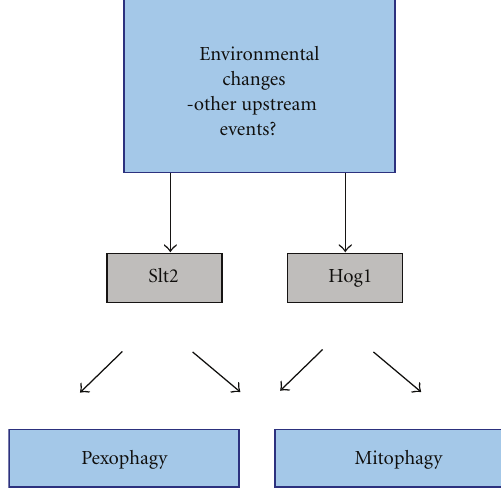
Figure 5: Signal transduction cascades regulating selective auto- phagy in yeast. Mitogen-activated protein kinase (MAPK) cascades contribute to di ff erential regulation of selective autophagy path- ways. As recently shown, the Slt2 and Hog1 signal transduction pathways regulate both mitophagy and pexophagy [37, 96]. Besides the obvious role of environmental factors such as nutritional con- ditions, details of other upstream events are poorly